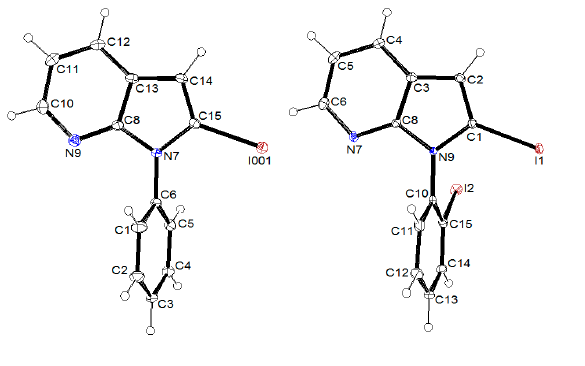
Figure 6. Calculated H charges and p K a values of 1-(2-thienyl)-7-azaindole ( 1g ; A ) and 1,1 ′ -(1,3-phenylene)bis(7-azaindole) ( 2k ; B ).